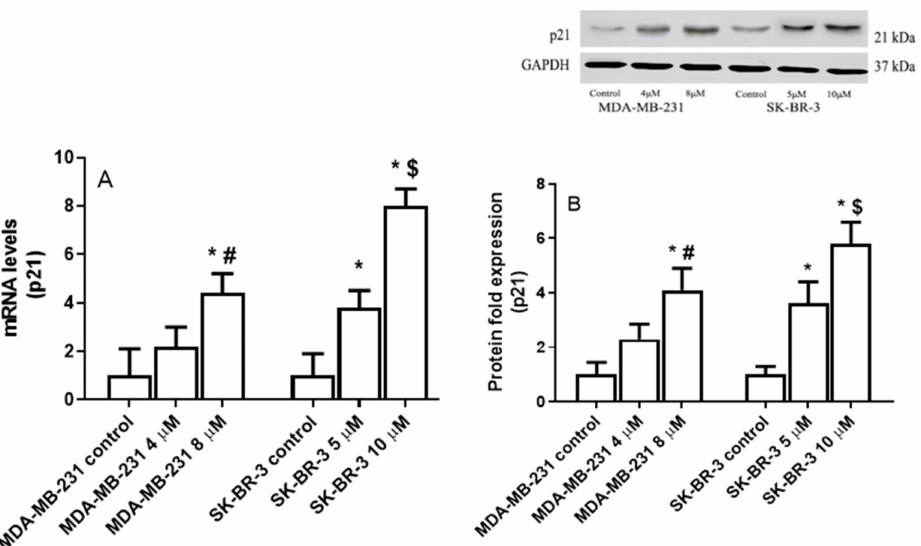
Figure 5. The effect of eugenol treatment on P21 mRNA and protein expression levels. ( A ) MDA- MB231 and SK-BR-3 cells were treated for 24 h. Thereafter, P21 mRNA expression levels were quantified by RT-PCR. ( B ) MDA-MB231 and SK-BR3 cells were treated for 24 h with eugenol 0, 4, and 8 µ M and 0, 5, and 10 µ M eugenol, respectively. Thereafter, P21 protein expression levels were determined by Western blot analysis. * indicates significant change from untreated cells, # indicates significant difference from MDA-MB-231 at eugenol concentration 4 µ M, and $ indicates significant difference from SK-BR-3 treated with 10 µ M eugenol at p < 0.05 based on a one-way ANOVA and the Tukey–Kramer post-ANOVA